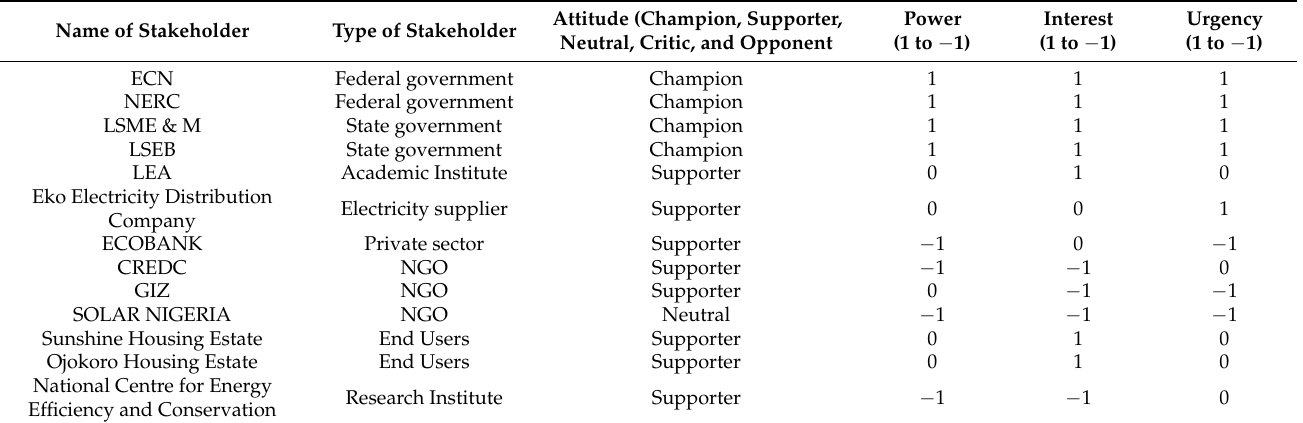
Table 3. Stakeholder overview and results of stakeholder analysis (with − 1 meaning ‘low’; 0 meaning ‘moderate’ or ‘neutral’; and 1 meaning